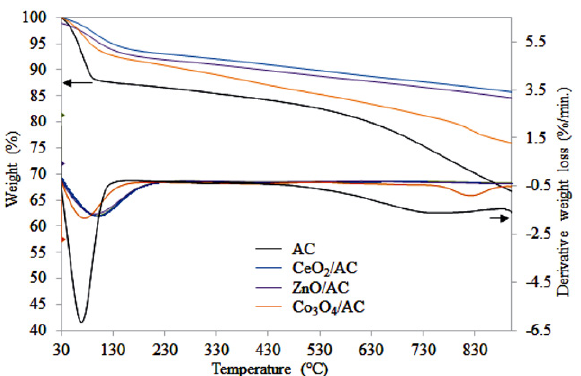
Figure 4. Thermal stability of the